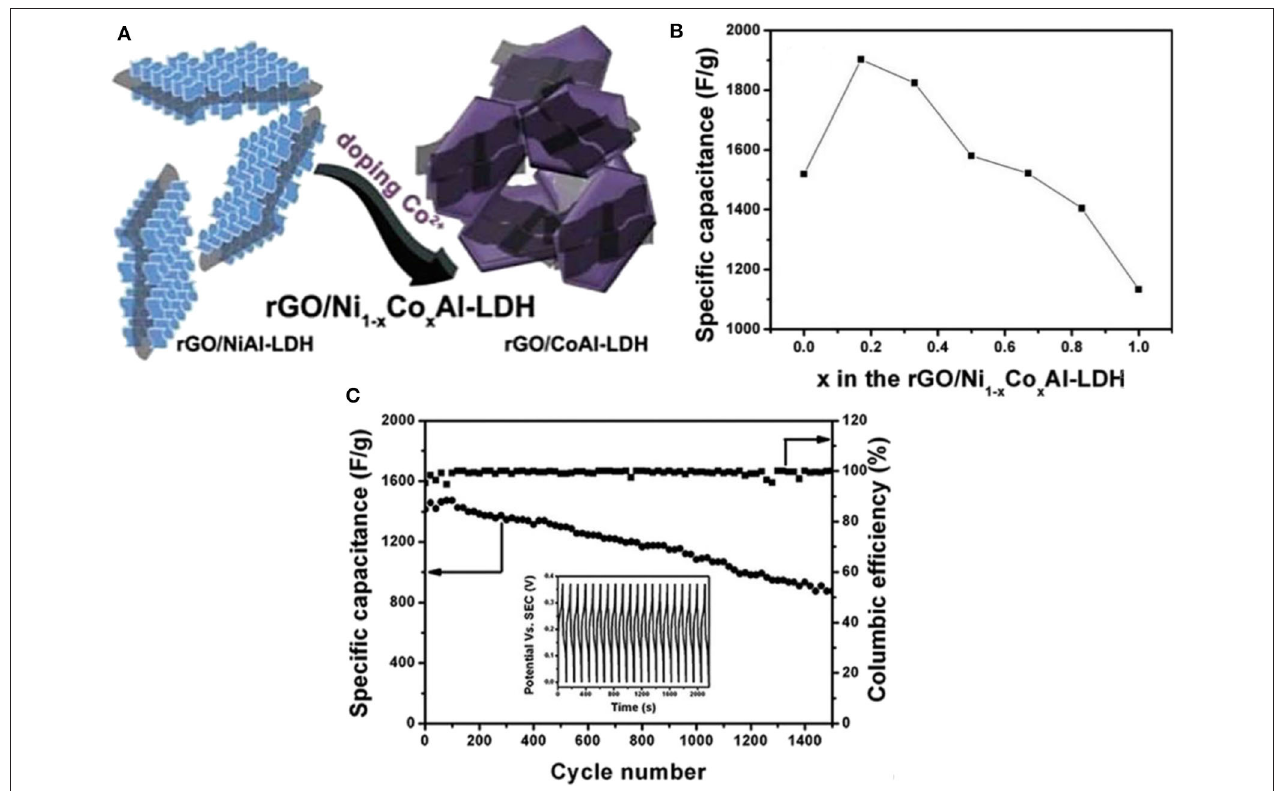
FIGURE 9 | (A) Schematic illustration for the shape conversion from rGO/NiAl-LDHs to the rGO/CoAl-LDHs composite, (B) Relationship between the specific capacitance and the doped Co content in rGO/Ni 1 − x Co x Al-LDHs, and (C) The cycling performance and corresponding Coulombic efficiency of rGO/Ni 0 . 83 Co 0.17 Al-LDHs at a current density of 10A g − 1 . The inset is the first 20 charge-discharge curves ( Xu et al.,